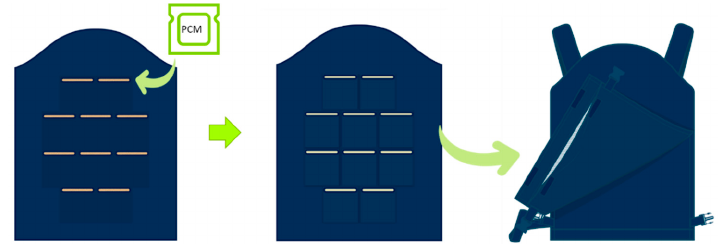
Figure 5. Study of the integration of PCM packages in the vest.